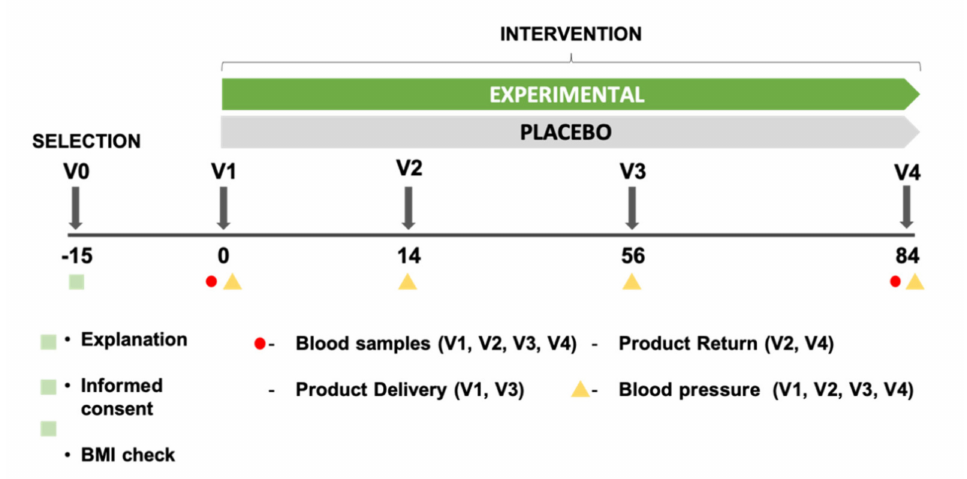
Figure 5. Graphical representation of the